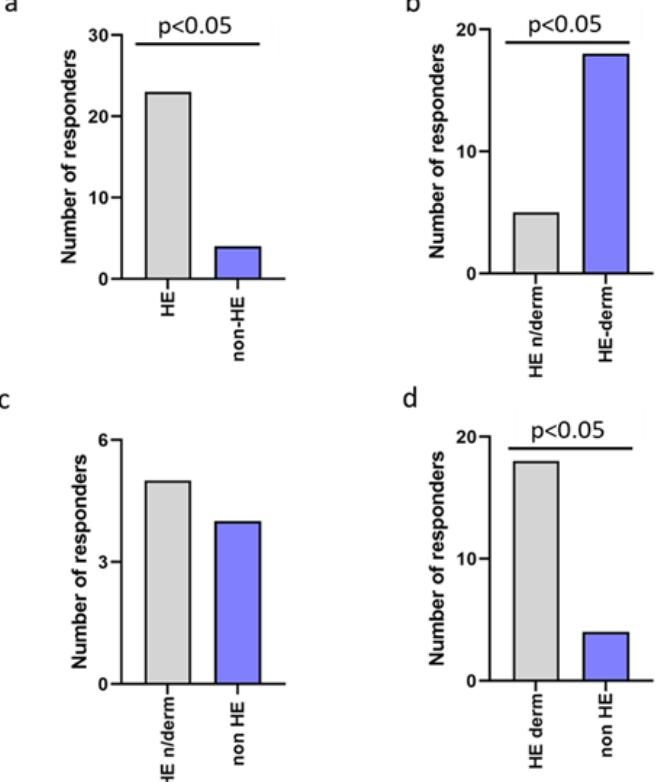
Figure 6. Comparison of the frequency of increased skin warmth reported in the study groups: ( a ) non-HE vs. HE; ( b ) HE-n/derm vs. HE-derm; ( c ) non-HE vs. HE n/derm; ( d ) non-HE vs. HE-derm.